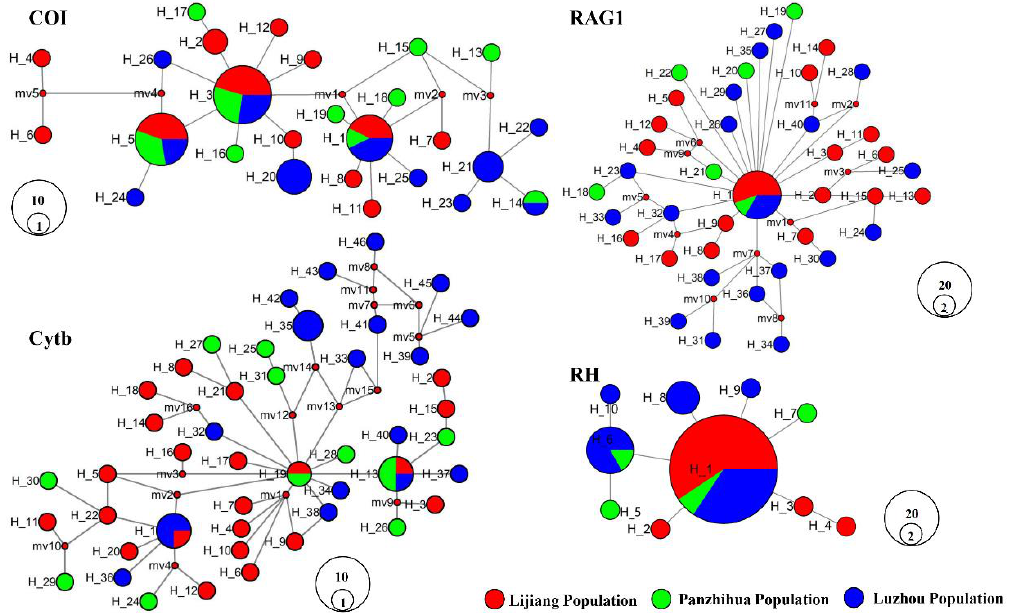
Figure 2. Median-joining network of the haplotypes of Jinshaia sinensis based on four genes. Each circle represents a haplotype, and its diameter is proportional to the frequency.